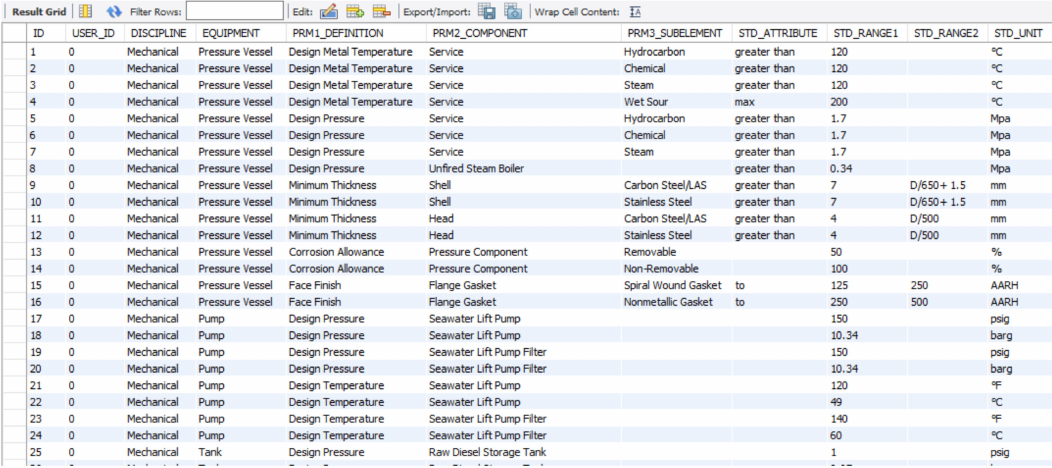
Figure 14. Data in the DPE Table.